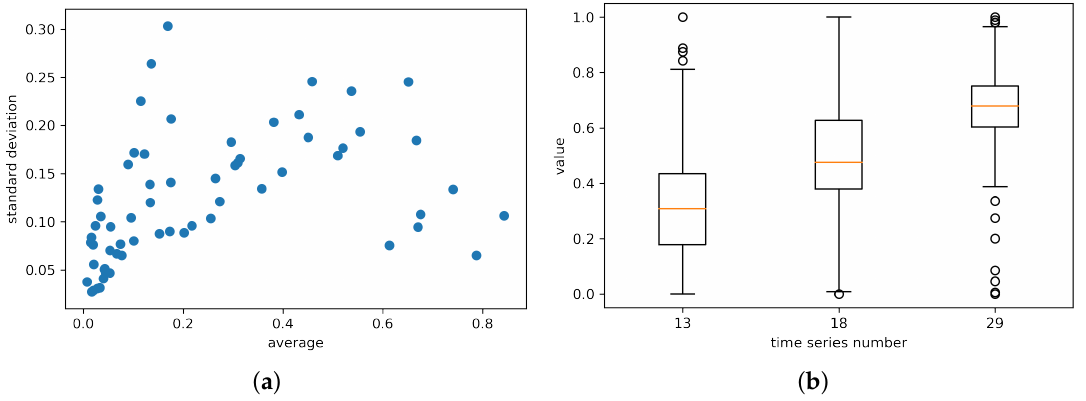
Figure 4. ( a ) Standard deviation graph based on the average of the normalized amount of data in each file. ( b ) Distribution of three time series of class